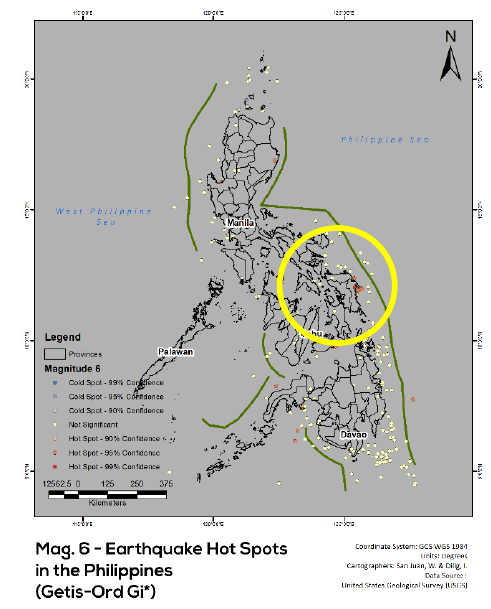
Figure 8. Mag.6-Earthquake Hot Spots in the Philippines